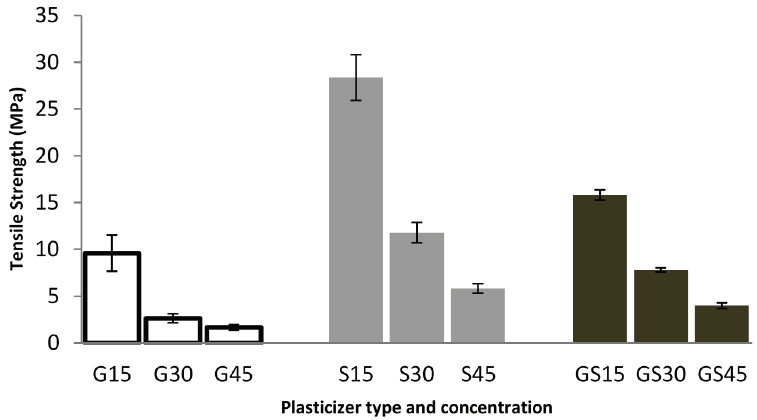
Figure 1. Effect of plasticizer type and concentration on the tensile strength of sugar palm starch (SPS)